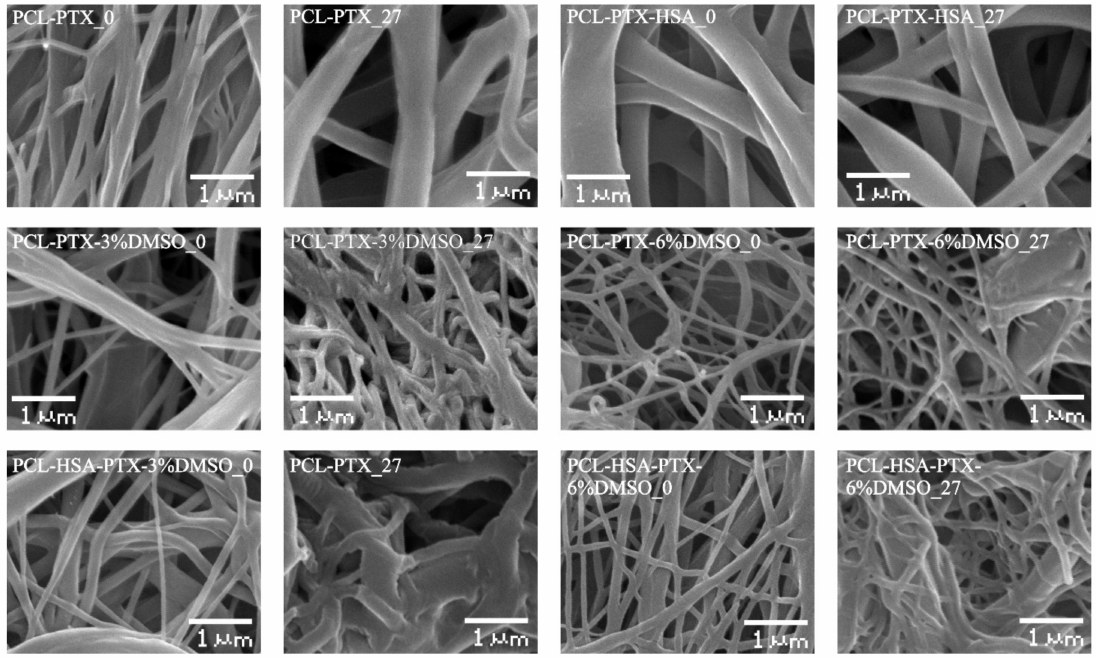
Figure 1. Microstructure of 3D matrices (SEM, × 3000 magnification). The digit following the matrix composition indicates the incubation time of the matrices in